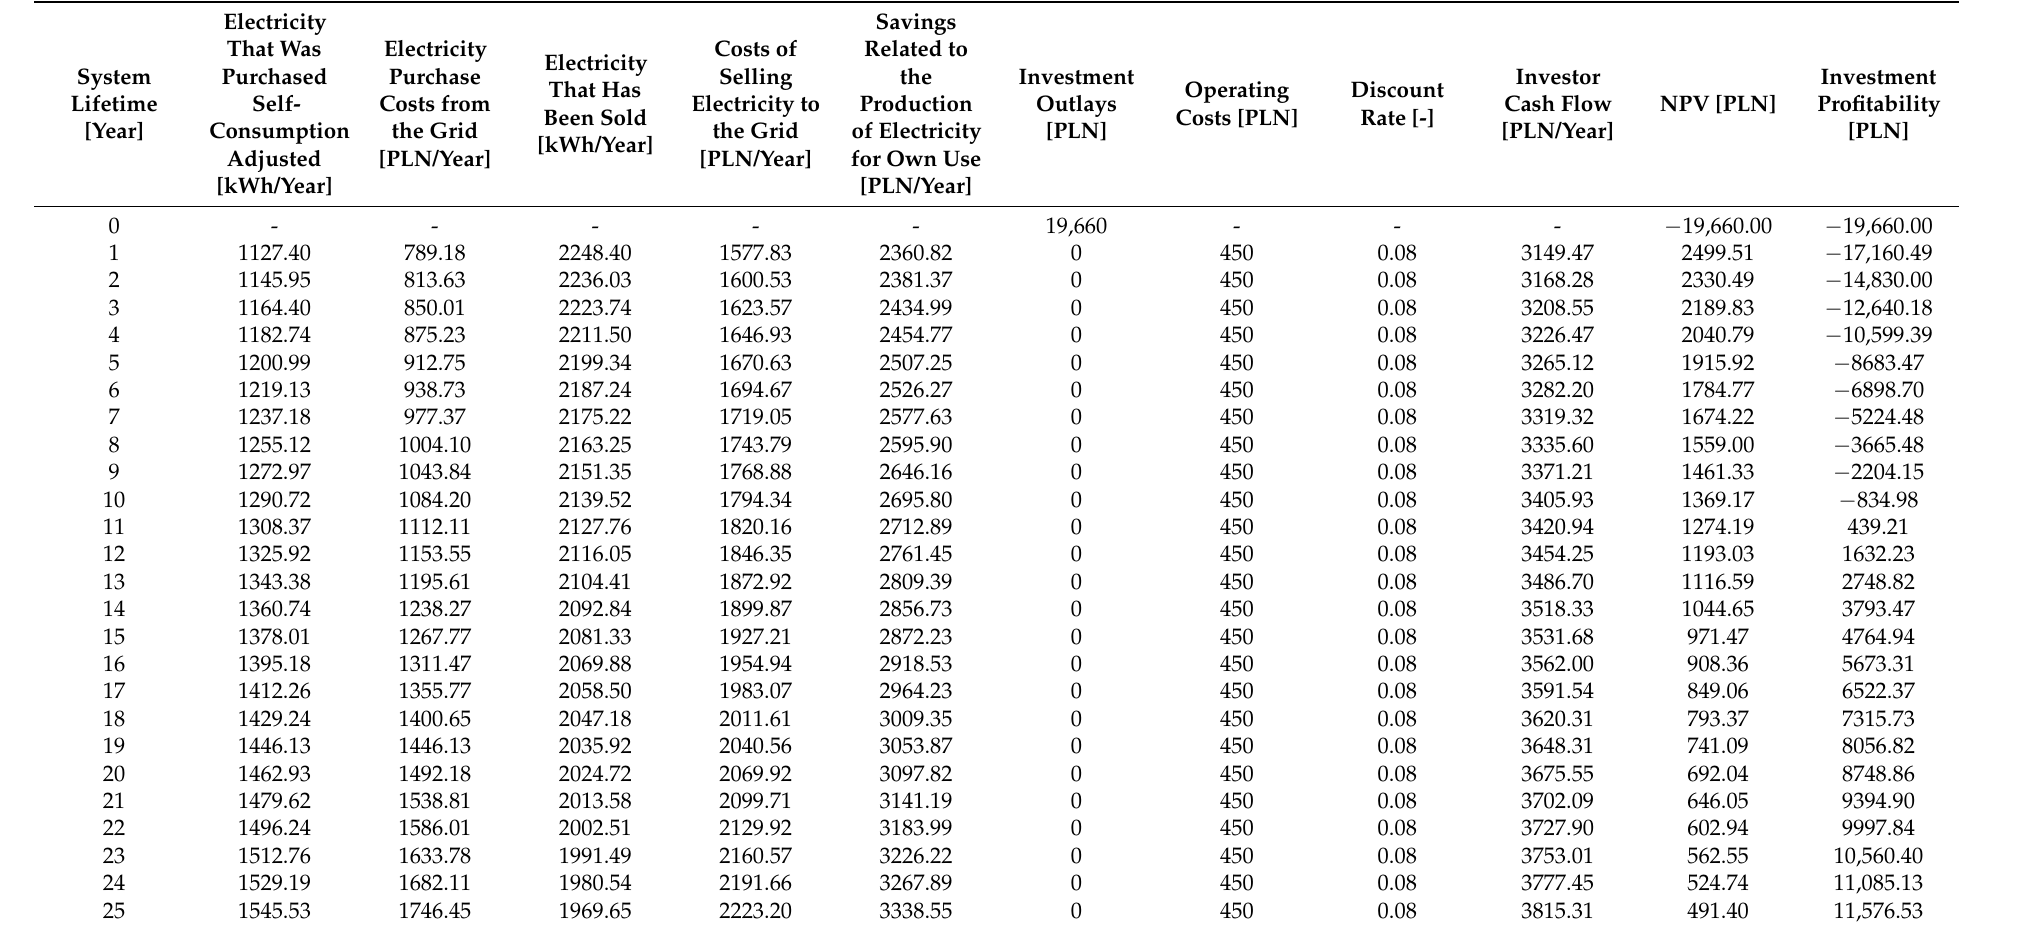
Table A9. NPV results of the PV installation for the net-billing system based on monthly prices, at a 60% self-consumption